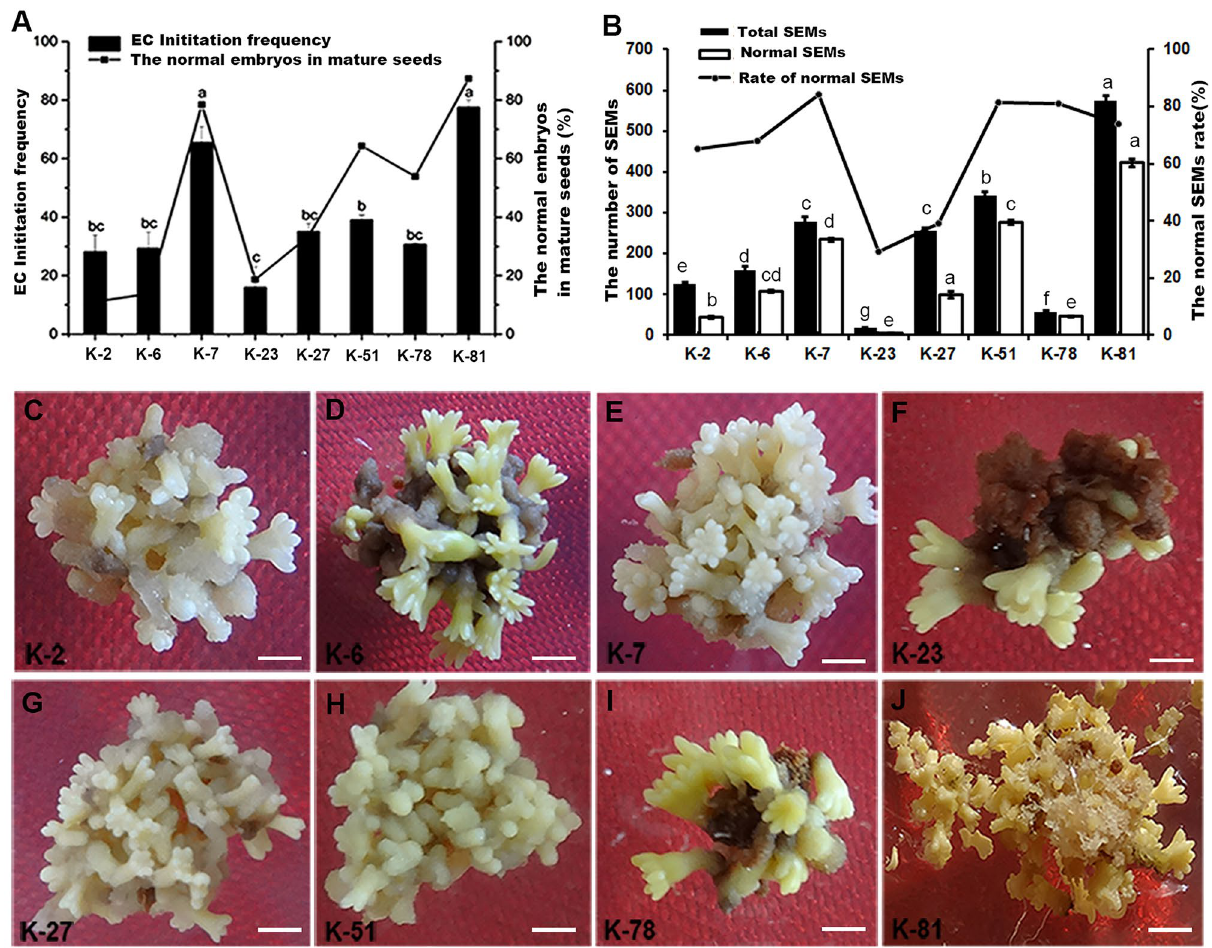
Figure 5. Effect of the maternal genotypes of donor plants on EC induction and SEMs maturation. ( A ) Effect of different lines and the seed filling rate on EC initiation. Bars denoted by the same letter within response variables are not significantly different ( P = 0.05) using Duncan’ s multiple range test. ( B ) The total number of generated SEMs and normal SEMs frequency in the different donor lines. ( C – J ) The SEMs maturation from different donor lines. The mature cotyledon embryos are milk white that obtained from K-2, K-7, K-27 and K-51. K-6, K-23 and K-78 generated mature cotyledon embryos were pale-yellow and same browned abnormal embryos. The embryos produced by K81 are pale-yellow with mature cotyledon embryos. Bars: 1 mm. All experiments were repeated more than three